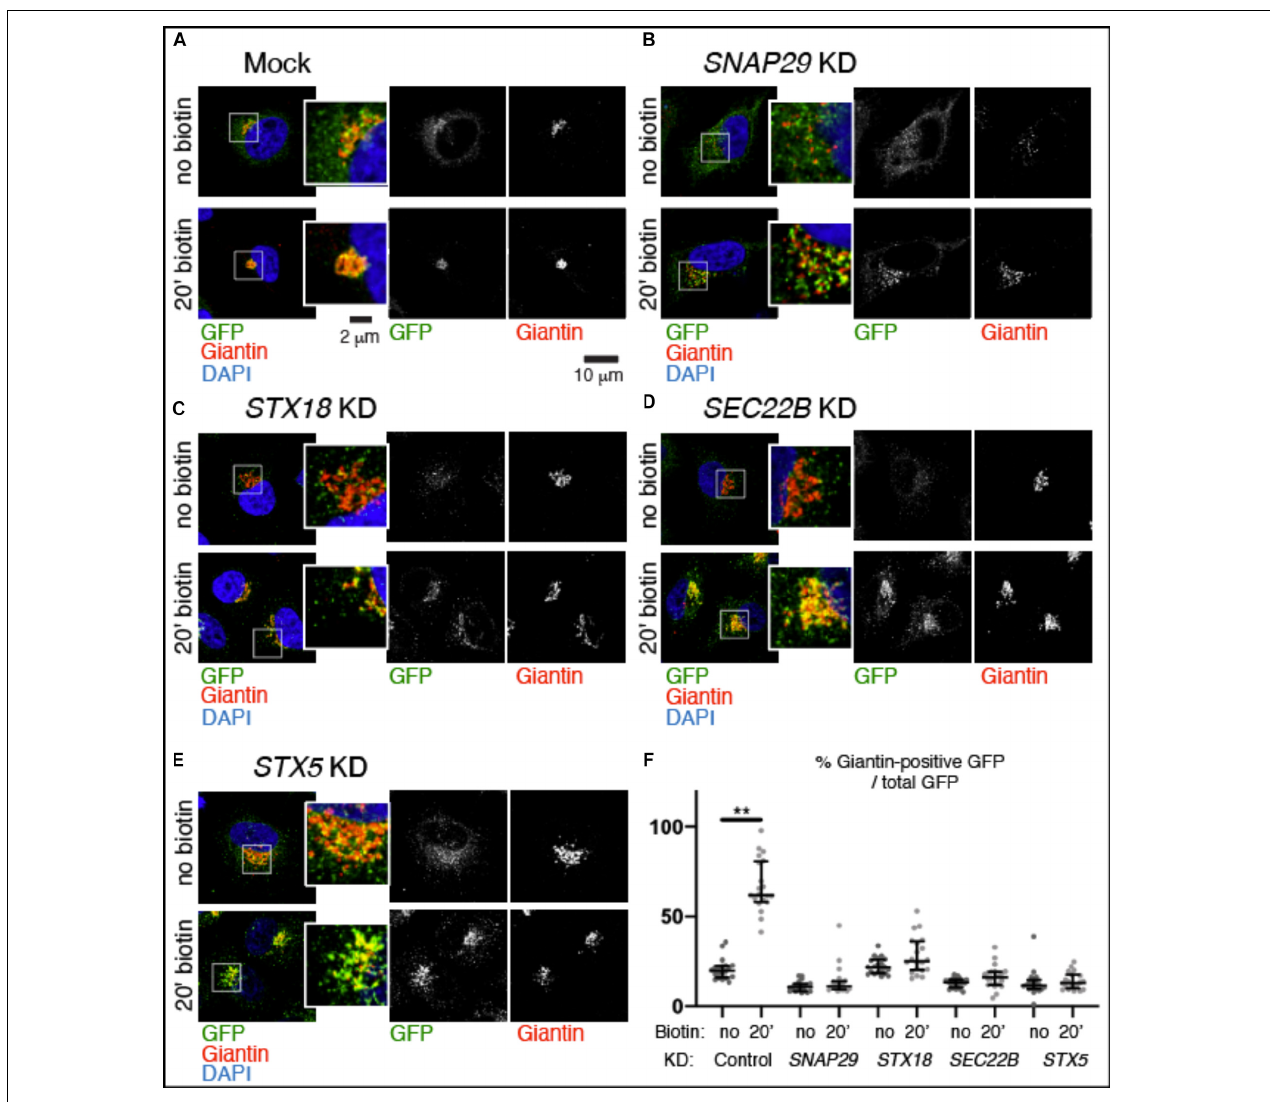
FIGURE 3 | SNAP29 contributes to ManII–SBP–GFP trafficking to the Golgi apparatus (GA). (A–E) Single confocal sections of HeLa cells stably expressing ManII–SBP–GFP, treated and stained as indicated. The EGFP pattern has been imaged before addition of biotin (no biotin) and 20 min after addition of biotin (20 min biotin). The insets show close-ups of the GA and surrounding areas. (F) Quantification of the ratio of the Giantin-positive EGFP signal over total, relative to the experiment in panel (A–E) . SNAP29, as well as the endoplasmic reticulum and GA SNAREs STX18, STX5, and SEC22B, appears to support ManII–SBP–GFP trafficking to the GA. The median with interquartile range is shown, and the p -value is obtained by Dunn’s multiple-comparisons